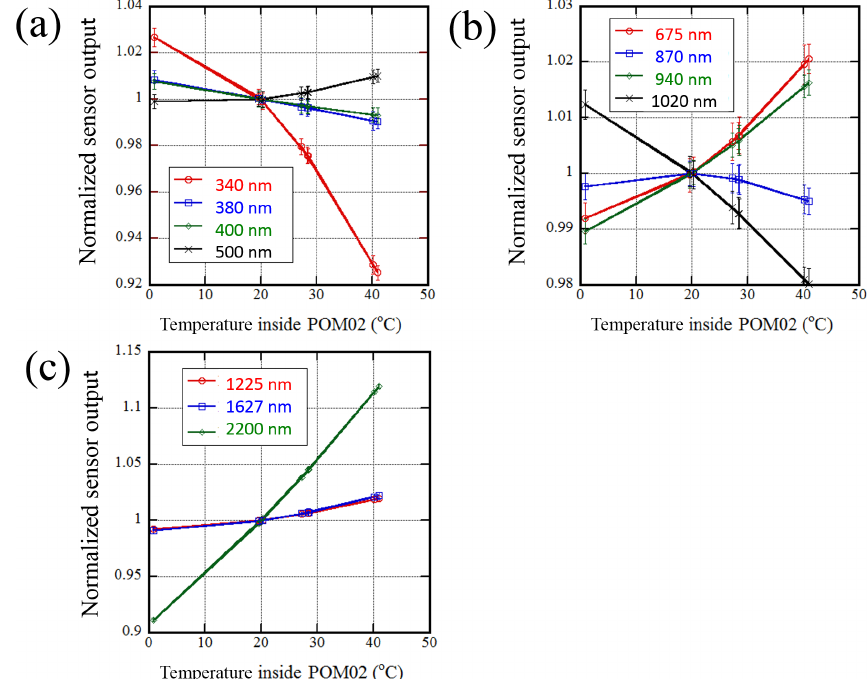
Figure 2. Relation between the sensor output and the inside temperature near the filter wheel for POM-02 (calibration reference). The sensor output is normalized by the output at 20 ◦ C. The error bars are the standard deviation. Panel (a) represents 340, 380, 400, and 500nm. Panel (b) represents 675, 870, 940, and 1020nm. Panel (c) represents 1225, 1627, and 2200nm.